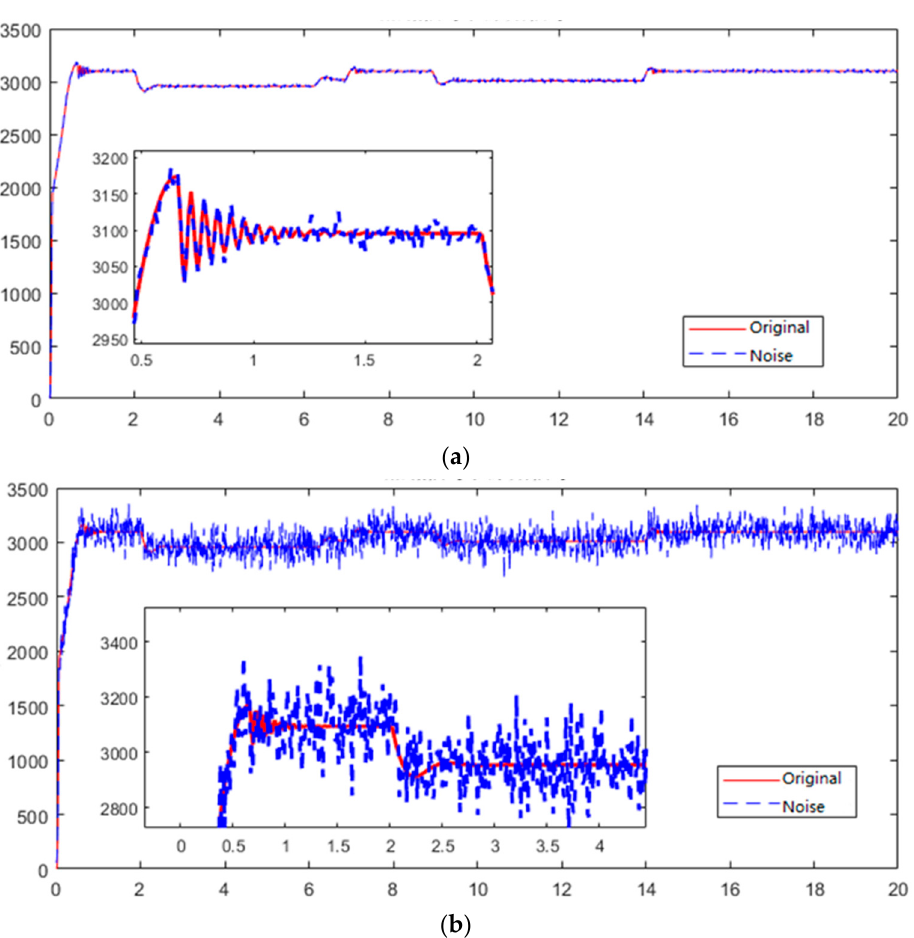
Figure 14. The pump outlet pressure signal under different signal–noise ratios. ( a ) SNR = 90 dB. ( b ) SNR = 50 dB. ( b ) SNR = 50